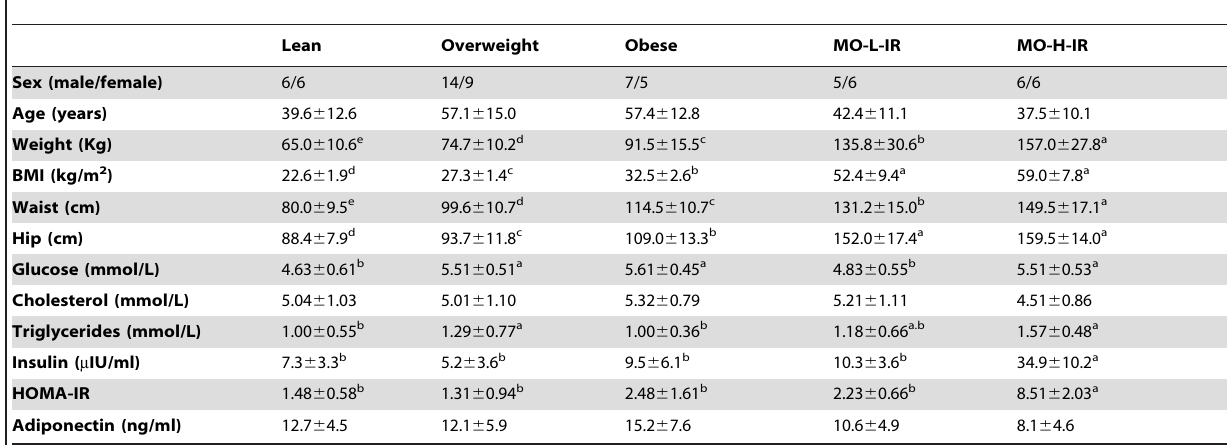
Table 1. Anthropometric and biochemical variables in the lean, overweight, obese and morbidly obese persons classified according to their insulin resistance